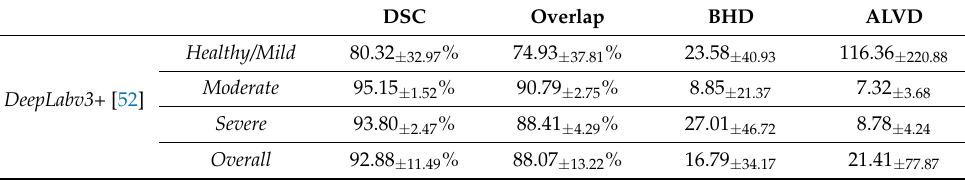
Figure 8. An illustrative example of the proposed segmentation for ( a ) healthy/mild, ( b ) moderate, and ( c ) severe COVID-19 infected lung. Note that red border (green border or yellow region) refers to ground-truth (segmentation). Table 3. Quantitative evaluation of the proposed segmentation system compared with other deep learning approaches. Note that DSC, BHD, and ALVD stand for Dice similarity coefficient, 95th- percentile bidirectional Hausdorff distance, and absolute lung volume difference,